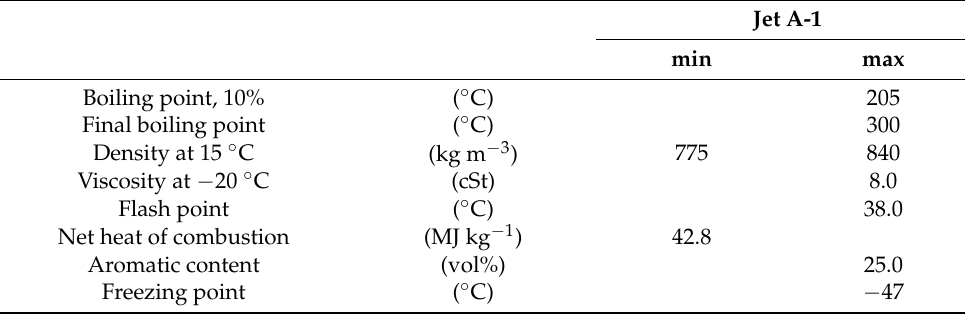
Table 5. Selected properties of jet A-1 fuel according to DCSEA 134/A [21].